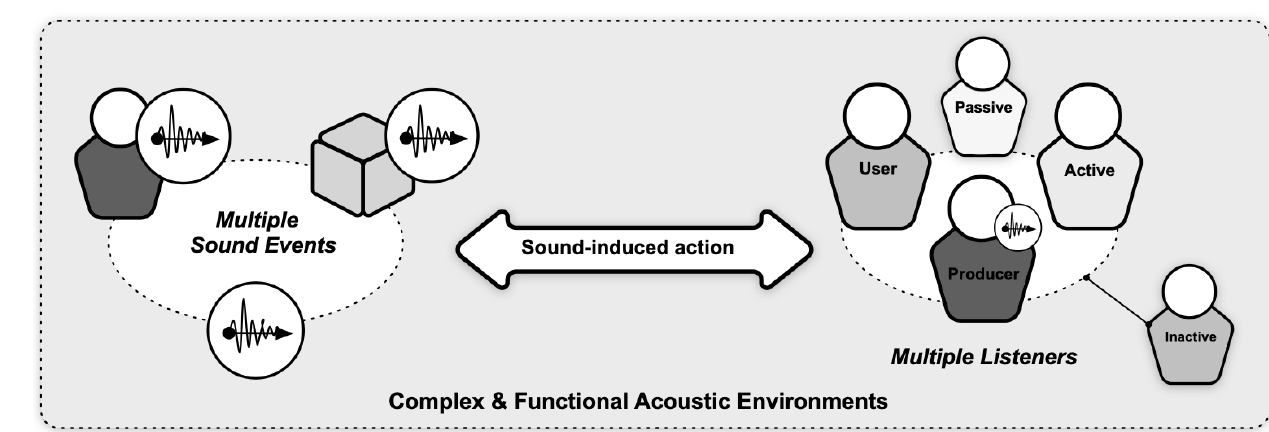
Figure 13. Challenges of complex acoustic environments with multiple sound sources and listeners.